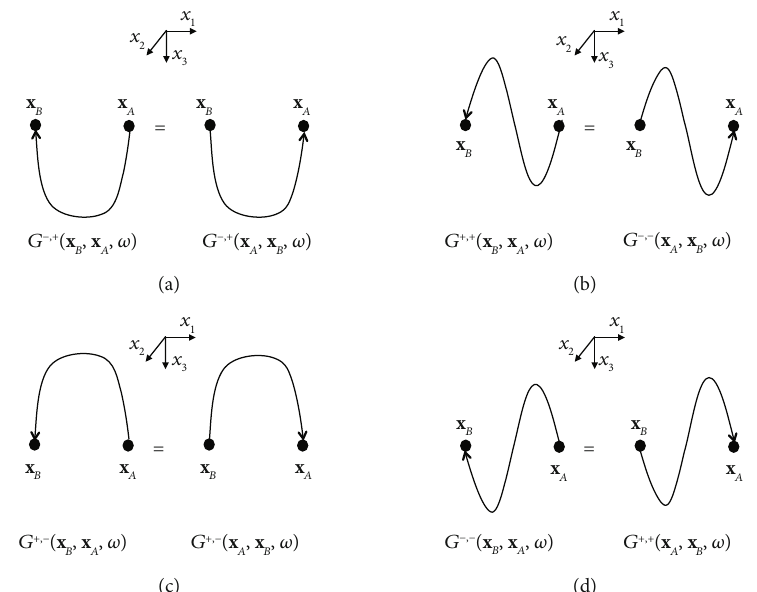
Figure 2: Visualisation of the source-receiver reciprocity relations for the fi eld-normalised one-way Green ’ s functions, formulated by equations (80), (81), (82), and (83). The “ rays ” in this and subsequent fi gures are strong simpli fi cations of the complete one-way wave fi elds, which include primary and multiple